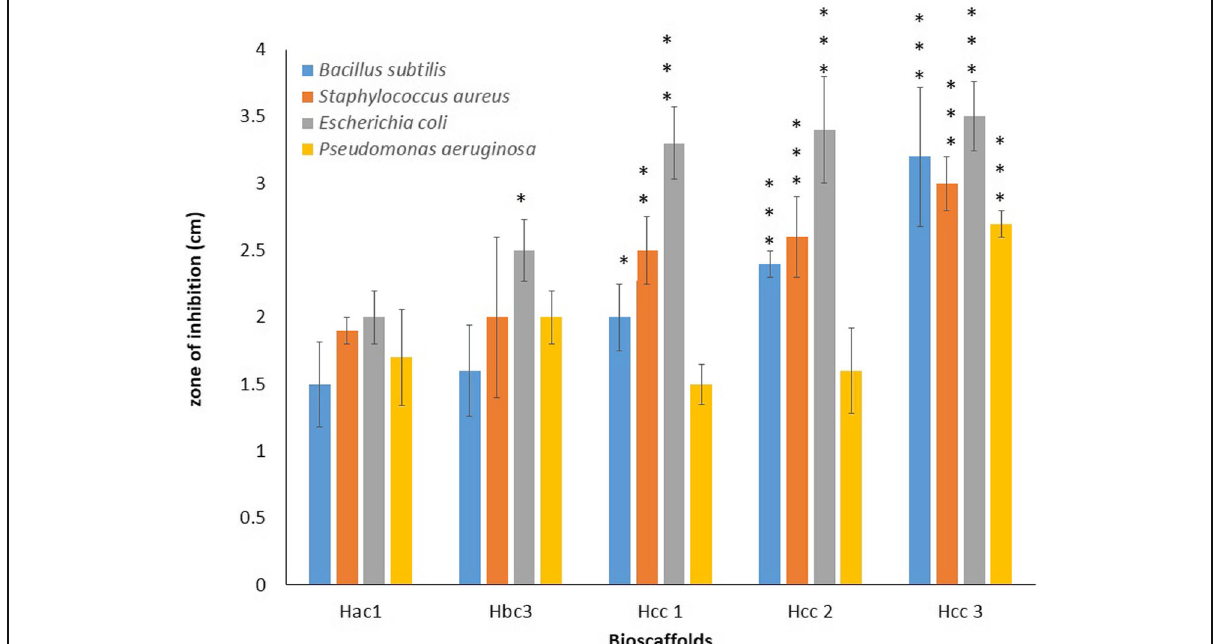
Fig. 5 In vitro antibacterial activity of prepared bioscaffolds. Data are represented as mean ± S.D. ( n = 3). Hac1 containing 1:1 ratio of chitosan and hydroxyapatite; Hbc3 containing 1.5 g of calcium chloride cross-linked with Hac1; Hcc1 to Hcc3 containing 250 to 750 mg of atorvastatin loaded on Hbc3. Data are expressed as mean ± S.D., statistically different at * p < 0.05, ** p < 0.01, and *** p < 0.001 in comparison to the control